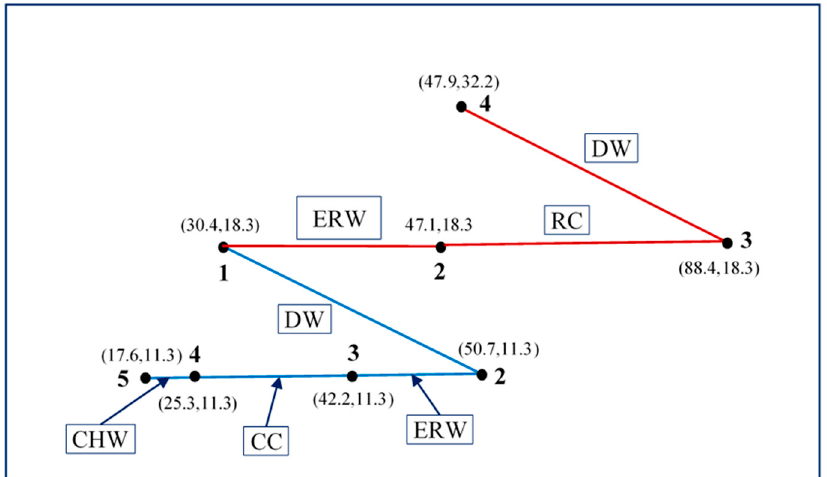
Figure 2. A typical psychrometric process of the proposed cooling system.